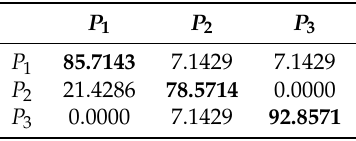
Table 4. Confusion matrix obtained by applying the Support Vector Machine (SVM) classifier to the leave-one-subject-out